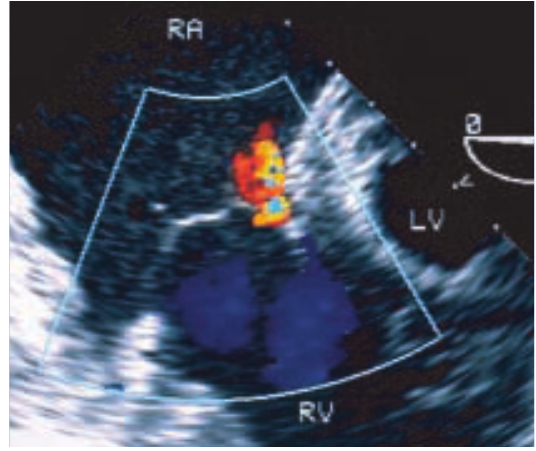
Pre-operative transoesophageal colour Doppler echocardio- graphy, showing bi-directional (right-to-left and left-to-right) shunt trough the atrial septal defect.